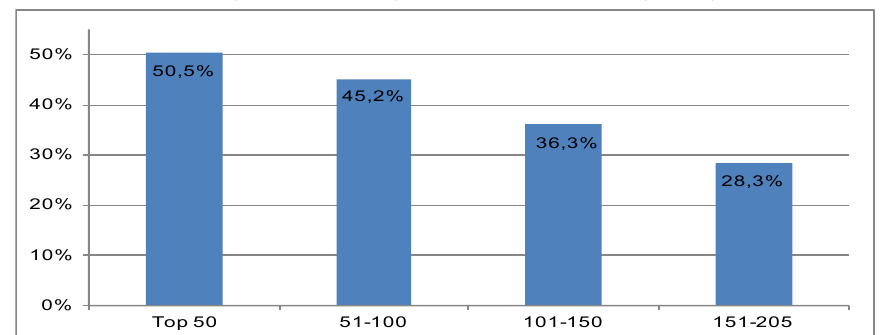
Average score percentage per market capitalisation